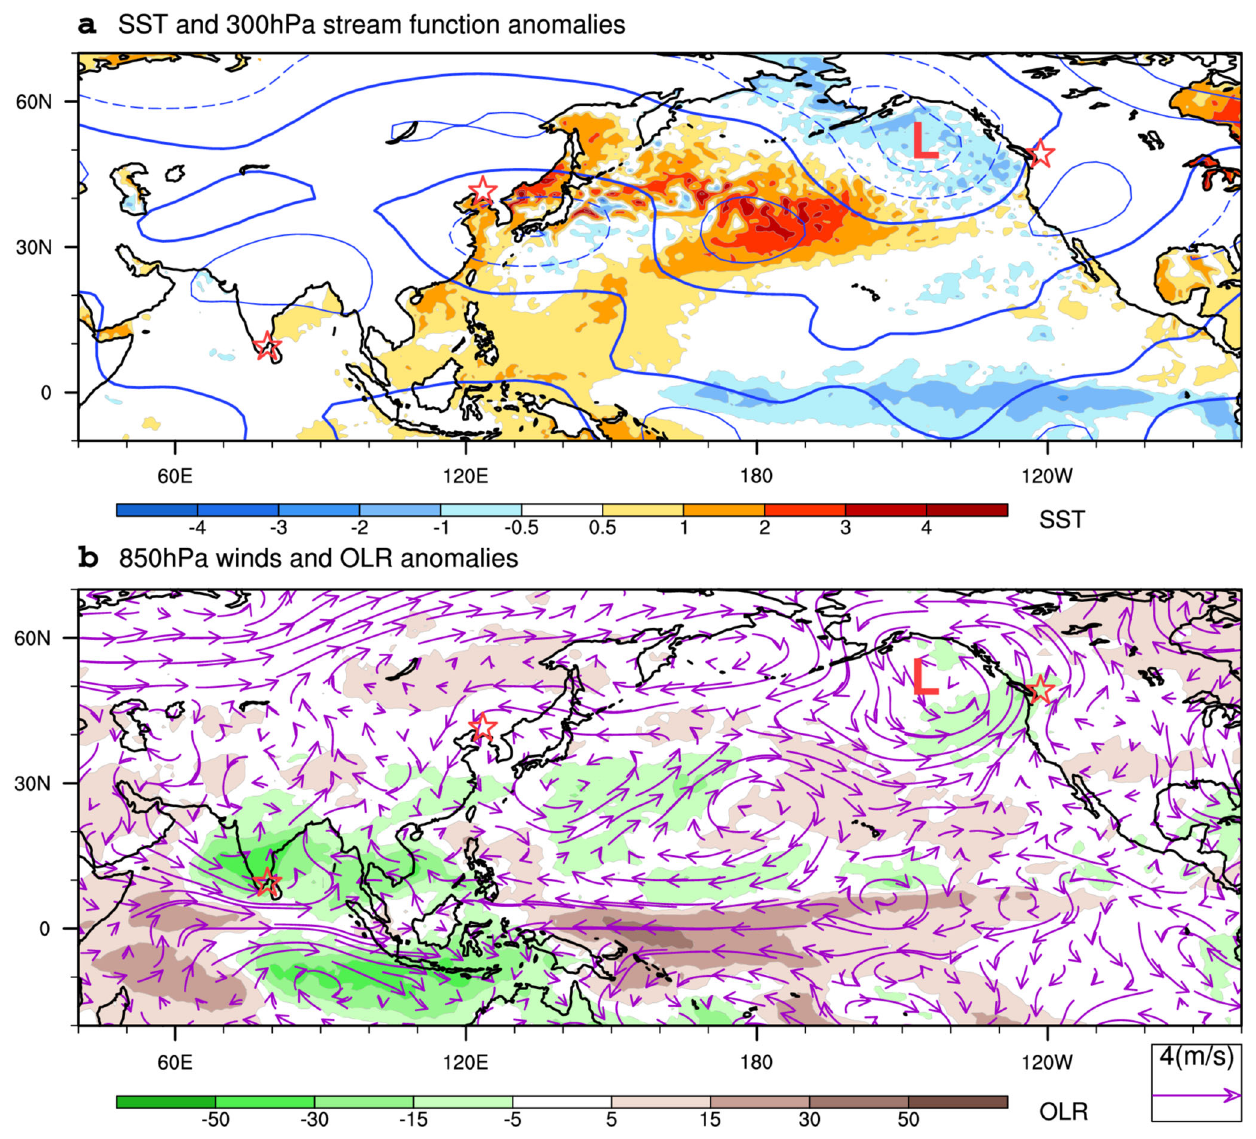
Fig. 4 Climate mean anomalies averaged from October 15 to November 30, 2021. a SST (shading) and upper-level (300 hPa) stream function (contours with interval at 5 × 10 6 m 2 S − 1 ) anomalies. b Low-level (850 hPa) winds and outgoing longwave radiation (OLR) anomalies (shading). The stars indicate locations of extreme weather events over India, northeast China, and Canada. The Gulf of Alaska Low is